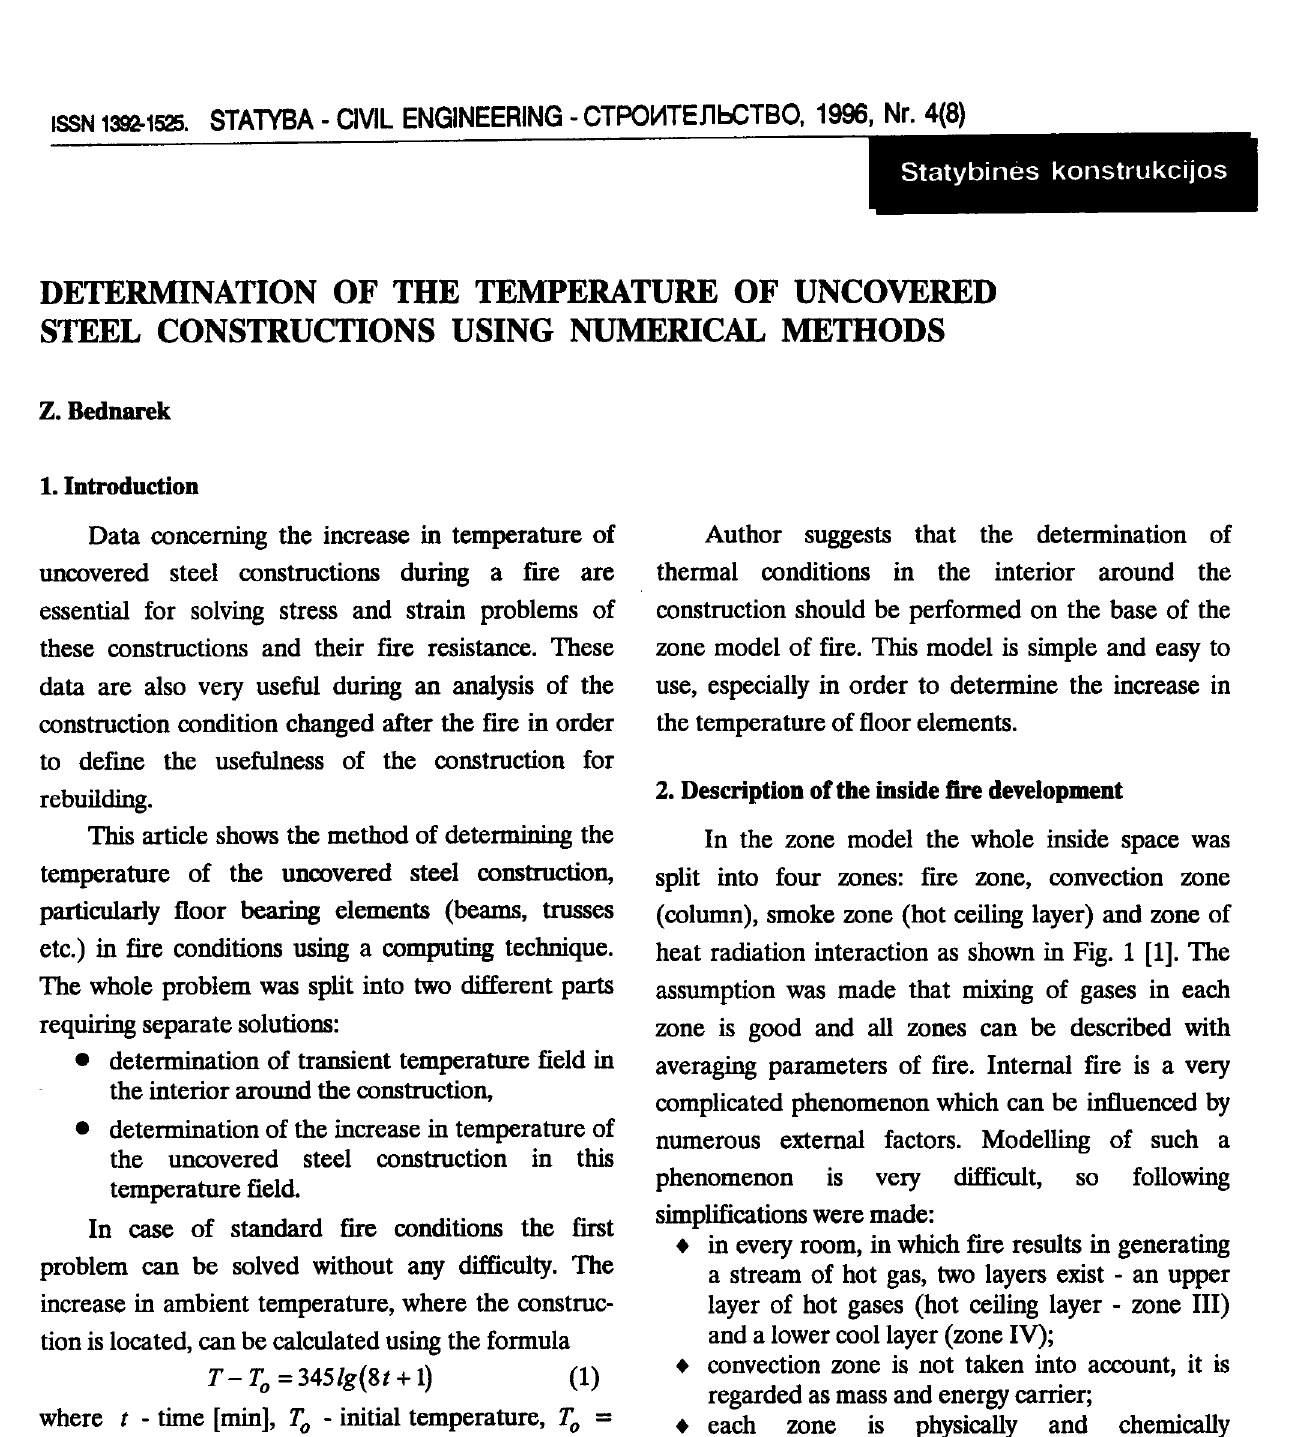
Fig. 1. Diagram zone model of fire: I - fire zone; II - convection zone (column); III -smoke zone (bot ceiling layer); IV- zone of beat radiation interaction (cool